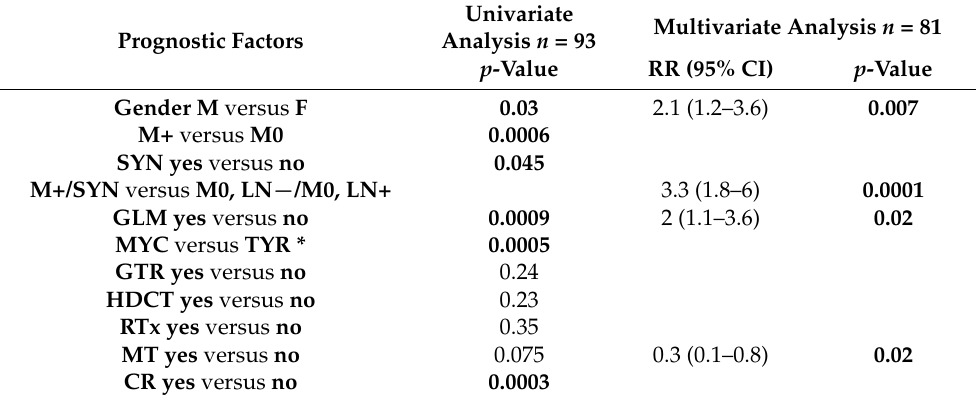
Table 3. Risk factors of overall survival according to univariate and multivariate